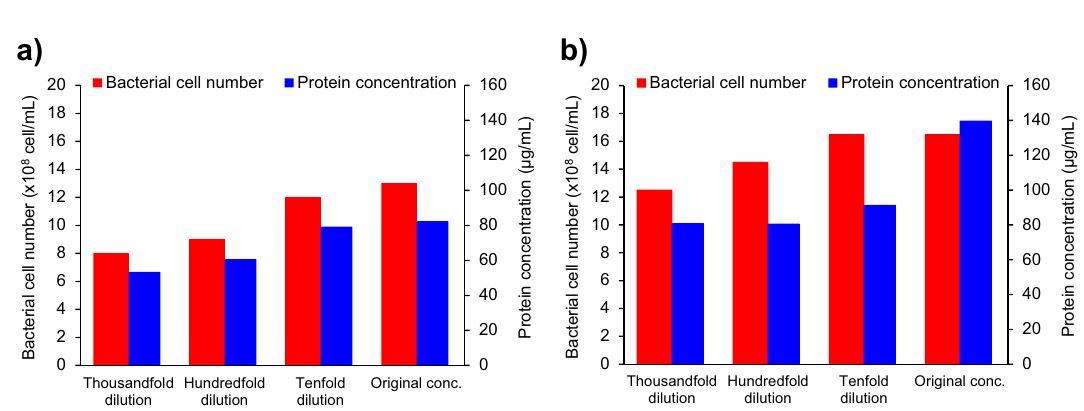
Figure 6. Bacterial cell number and protein concentration after 84 h cultivation of P . aeruginosa in the nanobubbles media. ( a ) Bacterial cell number (red bars, set on the left-hand axis) and protein concentration (blue bars, set on the right-hand axis) detected in the oxygen nanobubbles medium after 84 h cultivation. ( b ) Bacterial cell number (red bars, set on the left-hand axis) and protein concentration (blue bars, set on the right- hand axis) detected in the carbon dioxide nanobubbles medium after 84 h